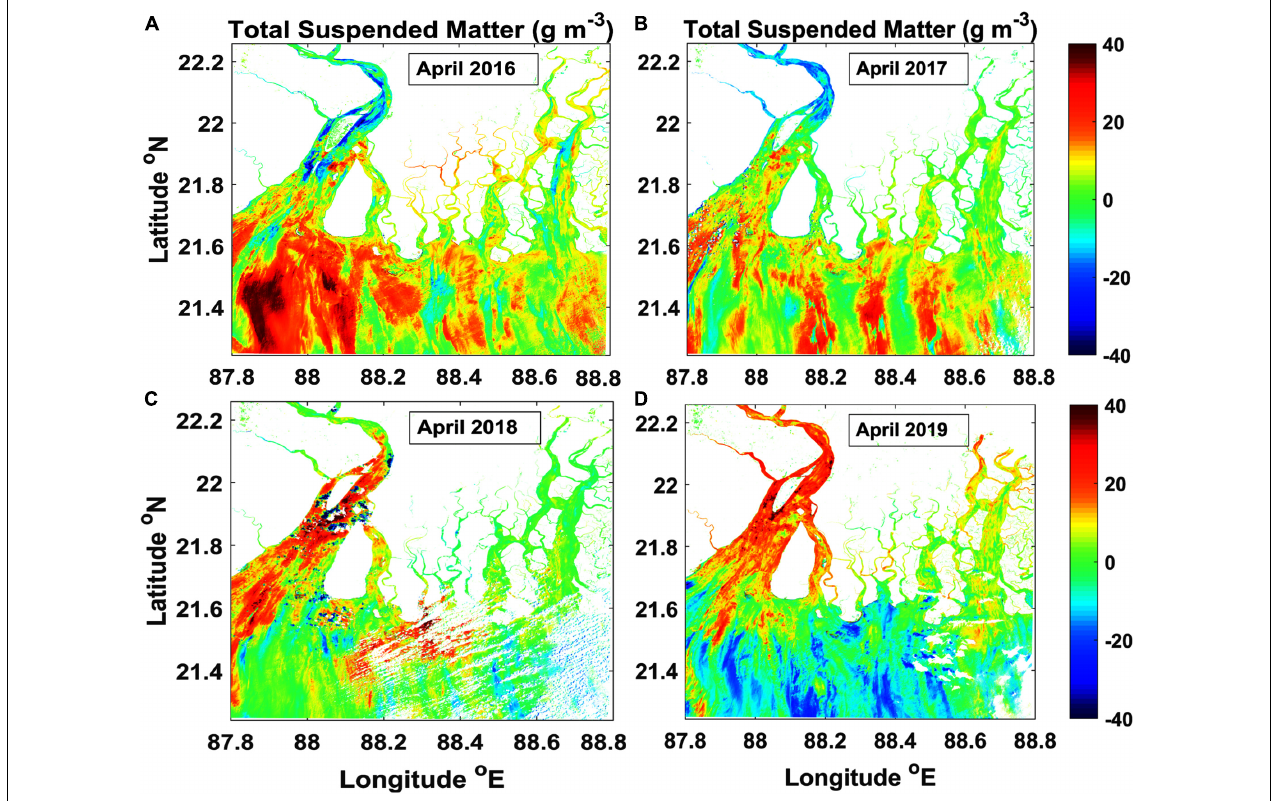
FIGURE 5 | Anomaly of TSM concentration during April (A) 2016, (B) 2017, (C) 2018 and (D)